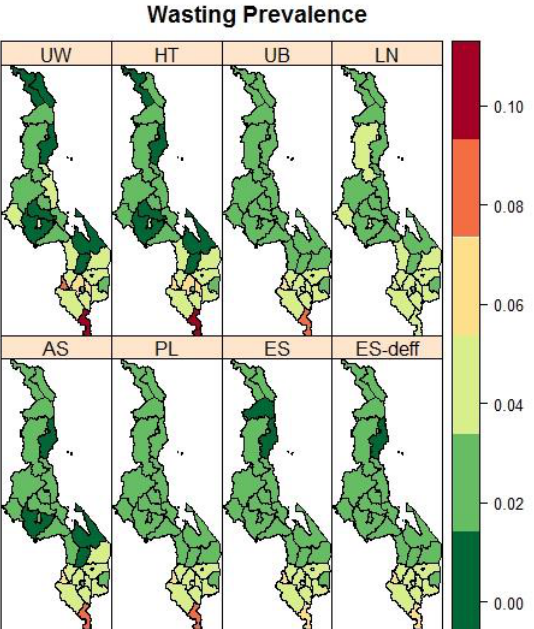
Figure 3. Maps of the observed (UW: unweighted and HT: Horvitz–Thompson) and spatial estimated prevalences of wasting (UB: Unadjusted Binomial estimator (Model 1), LN: Logit-normal estimator (Model 2), AN: Arcsine-square root transformation estimator (Model 3), PL: Pseudo-likelihood estimator (Model 4), ES: Effective Sample size estimator (Model 5), and ES-deff: Effective Sample size estimator using design effect (Model 6)) by the district in Malawi using 2015-16 MDHS.